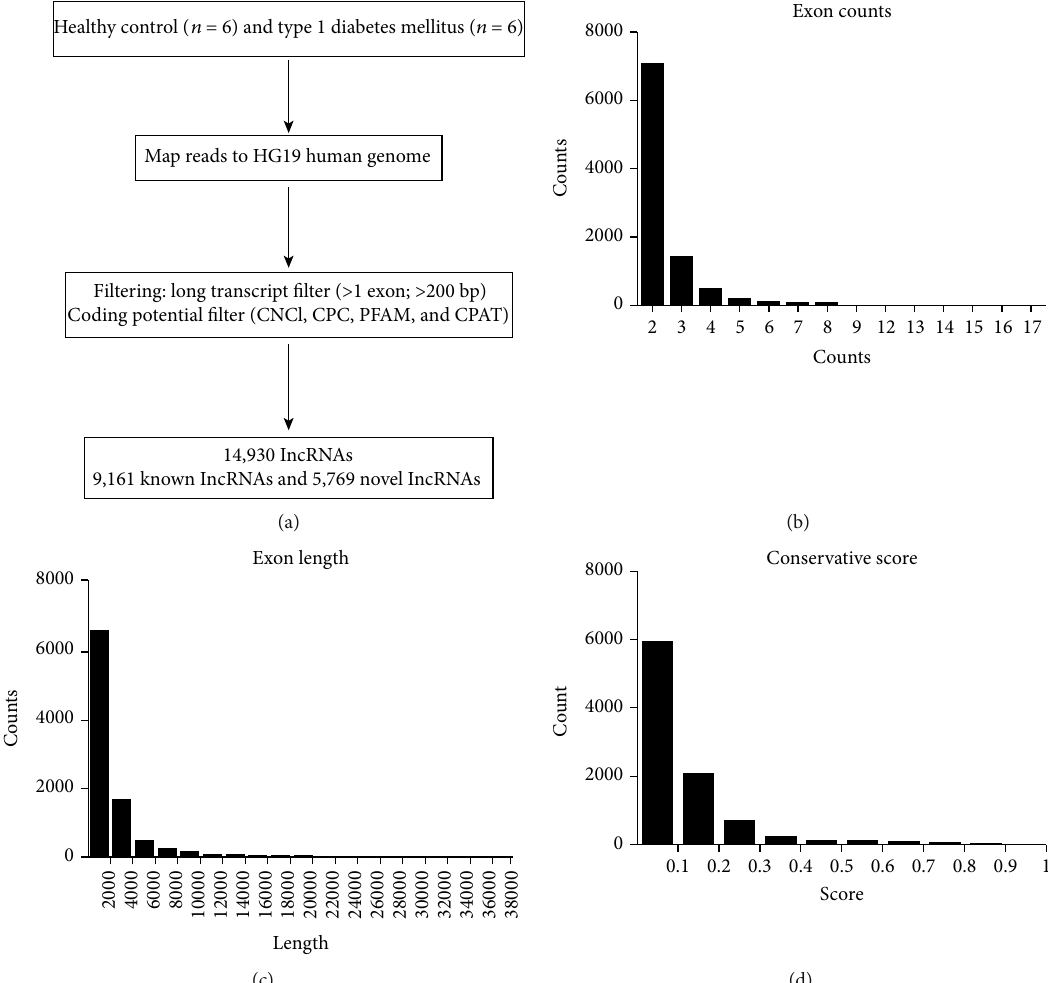
Figure 1: Transcriptomic landscape of T1D lncRNAs. (a) A schematic illustration of the procedure used to identify and de fi ne lncRNAs in the leukocytes of controls and T1D patients. (b) The transcripts of novel lncRNAs were mainly distributed in 2 exons, 3 exons, and 4 exons. (c) The largest number of novel lncRNA transcripts was concentrated at a length less than 2500nt. (d) The transcripts of novel lncRNAs were concentrated at the lowest conservation score